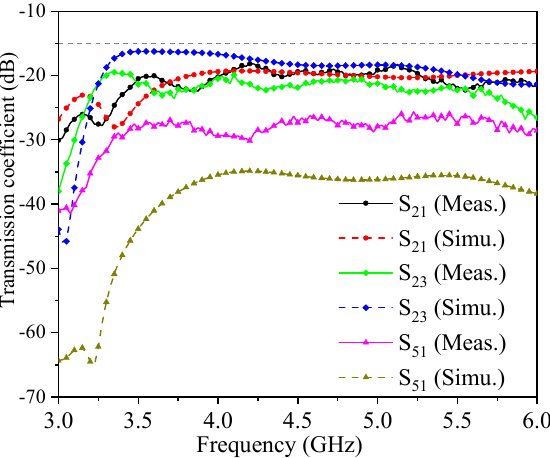
Figure 12. The measurement and simulation results of transmission coefficients of the presented antenna.